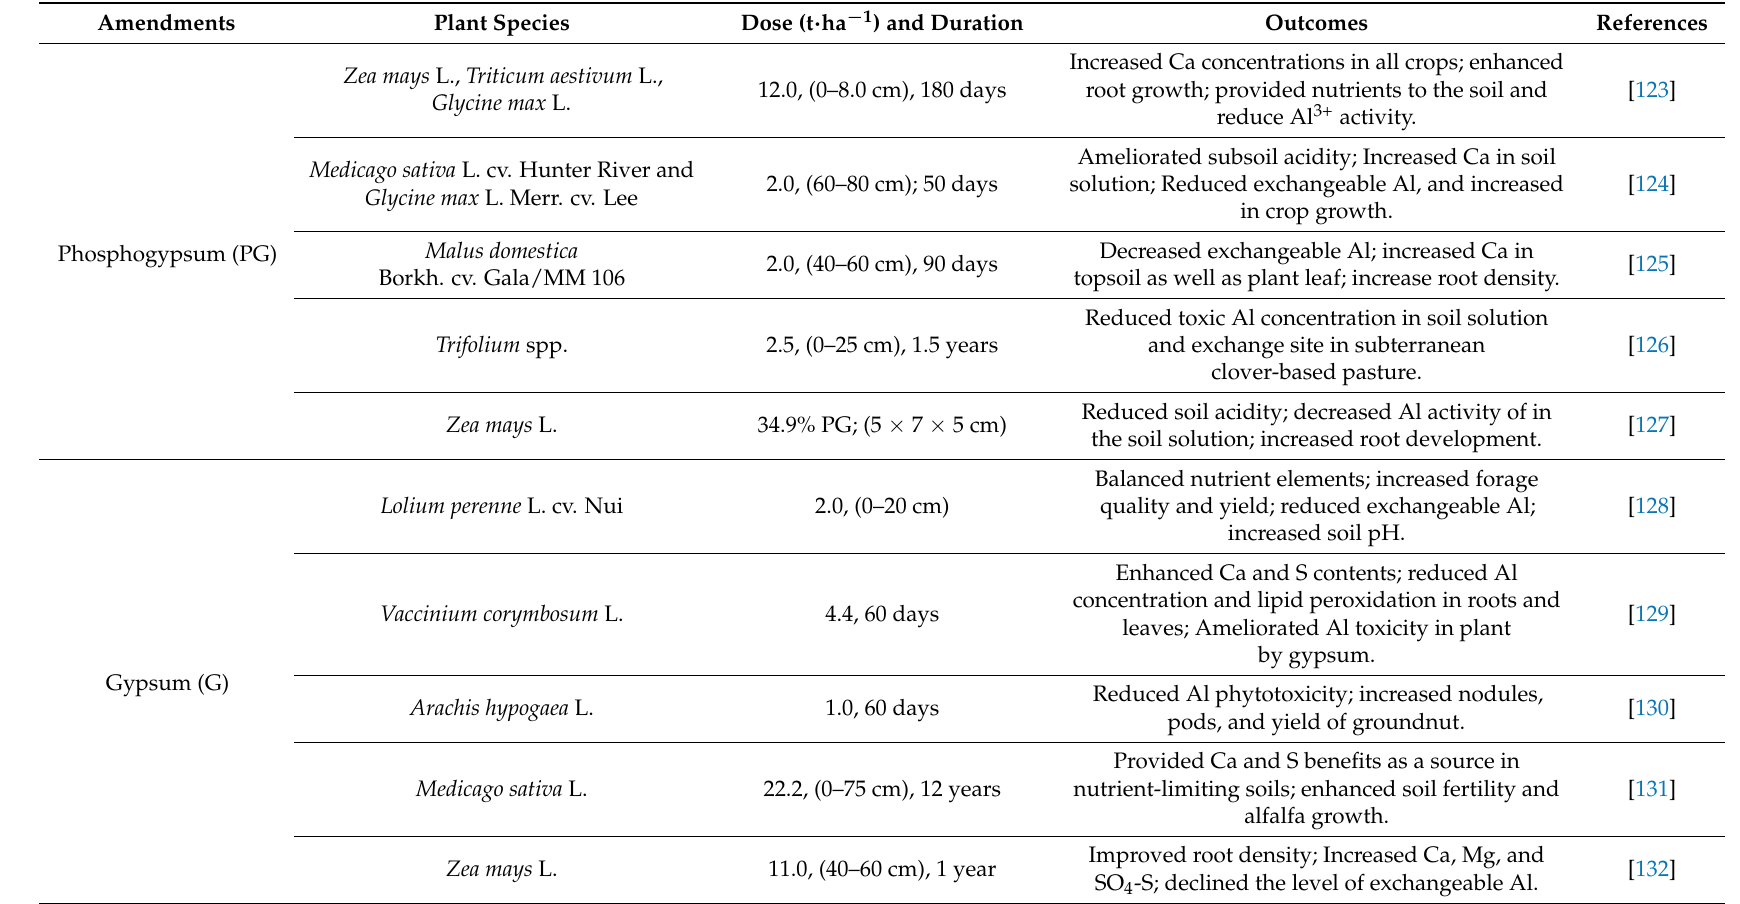
Table 4. Calcareous amendments-induced alleviation of Al toxicity in plants to acid